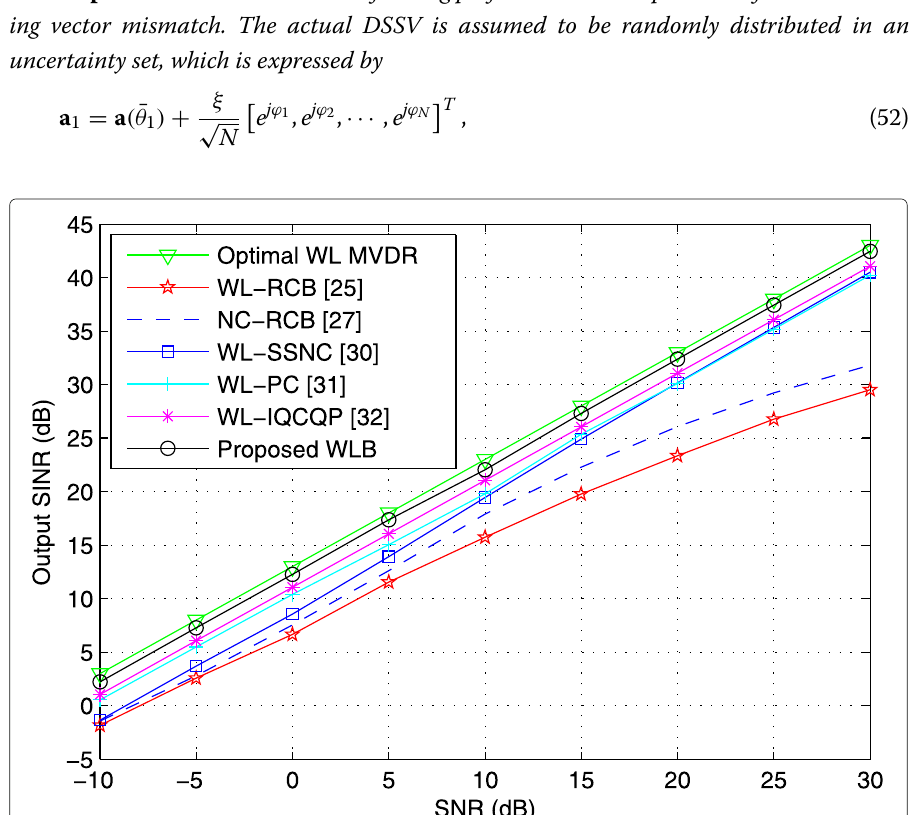
Fig. 8 Example 4. Output SINR of all WLBs versus the input